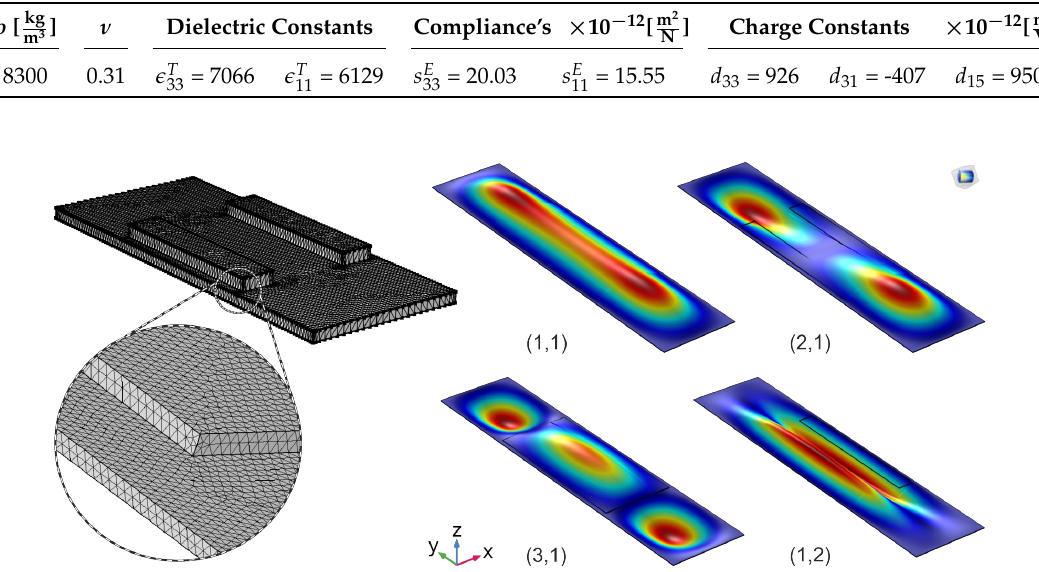
Table 1. Material constants for PZT-5K4 (Morgan Advanced Materials, Ohio, OH, USA) provided by